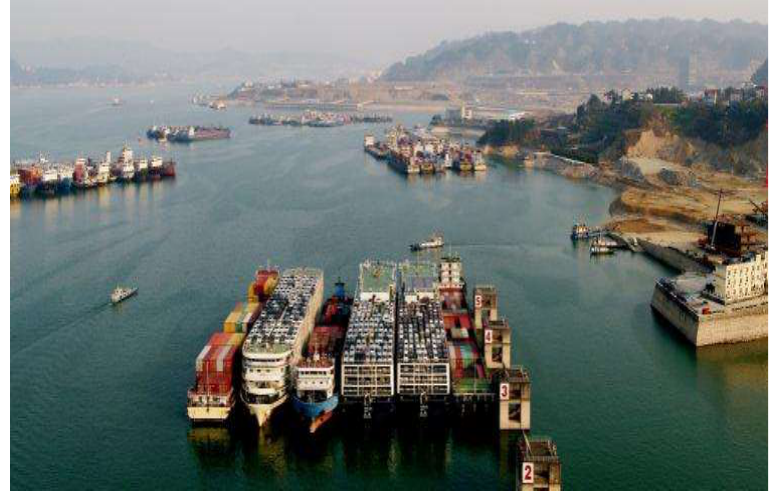
Figure 1. The description of shipping and logistics on the golden waterway of the Yangtze River [3].